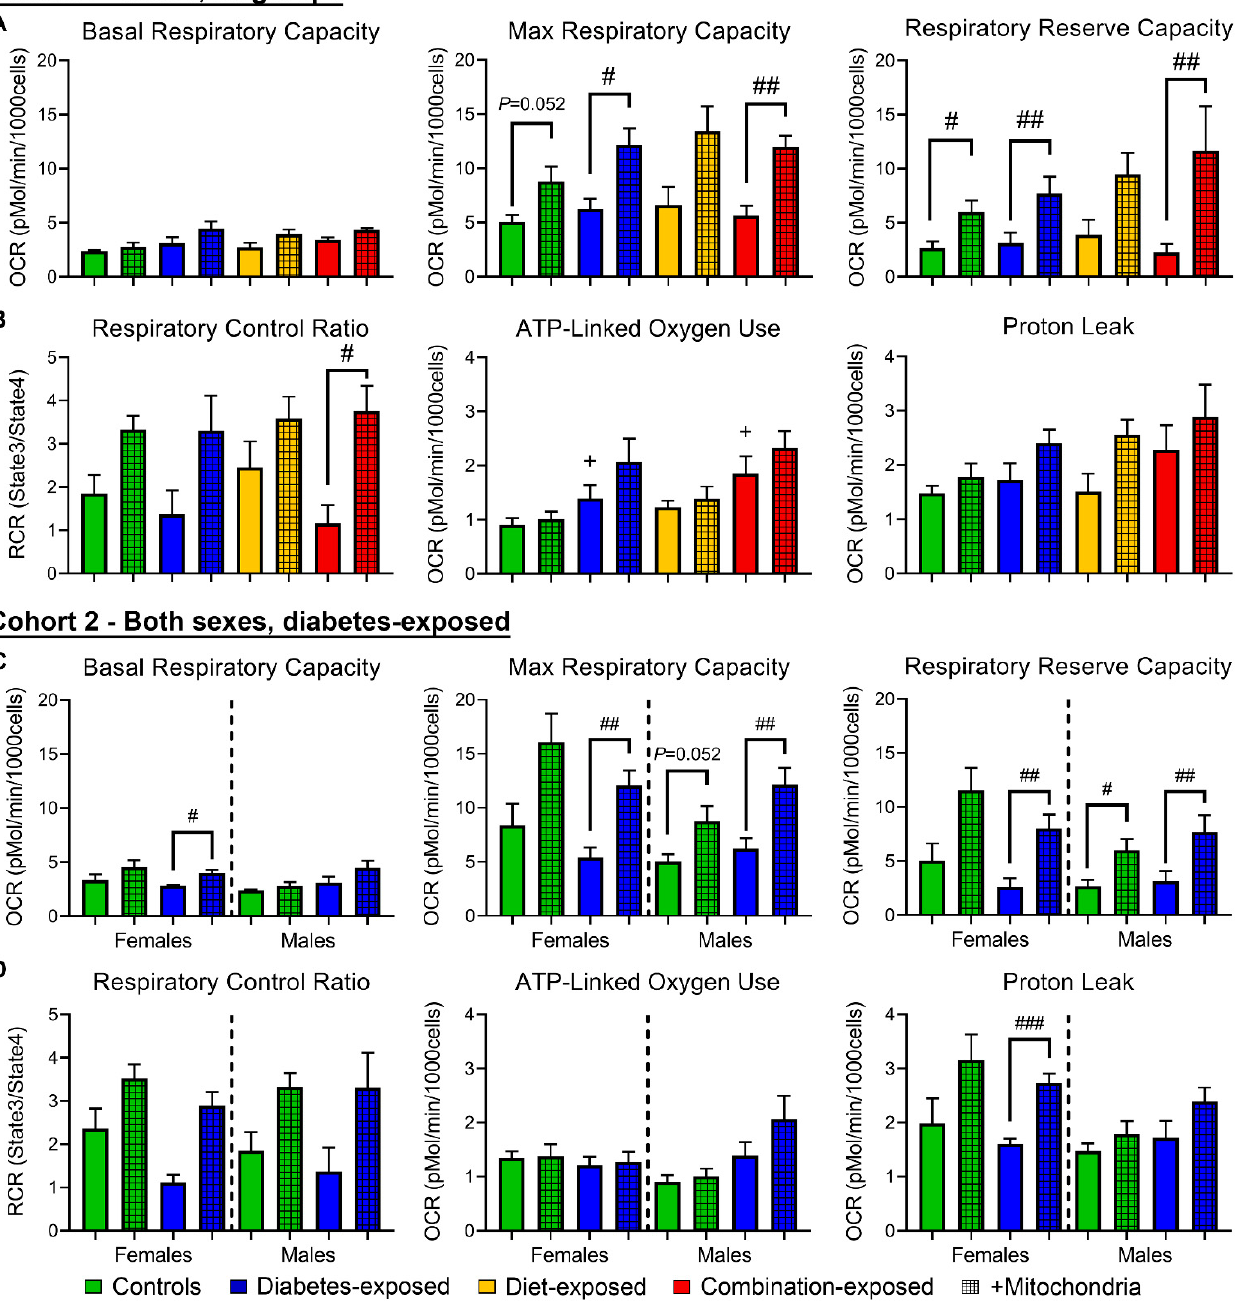
Figure 3. PGDM-exposed males, but not females, use more oxygen for ATP production, and while mitochondrial transfer may benefit males, it may put females at greater risk of ROS production. ( A ) Basal, FCCP-stimulated maximal, and reserve respiratory capacities and ( B ) respiratory control ratios, oxygen consumed in ATP production, and proton leak of male cardiomyocytes (CM) determined by mitochondrial stress test supplemented with mitochondrial transfer. ( C , D ) Respiratory parameters from PGDM-exposed CM of both sexes. N = 4–6 per group. Data represent mean ± SEM. P ≤ 0.05: + diabetes effect by 2-way ANOVA, # mitochondrial effect by 1-way ANOVA. ## P < 0.01, ### P <